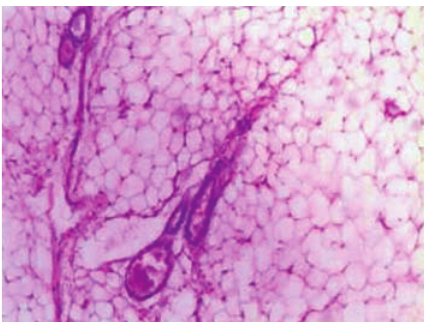
Figure 5: Histopathology of the excised specimen showing lobu- lated adipose tissue with scattered small vascular channels in the collagenous septa around the lobules (H&E, ×